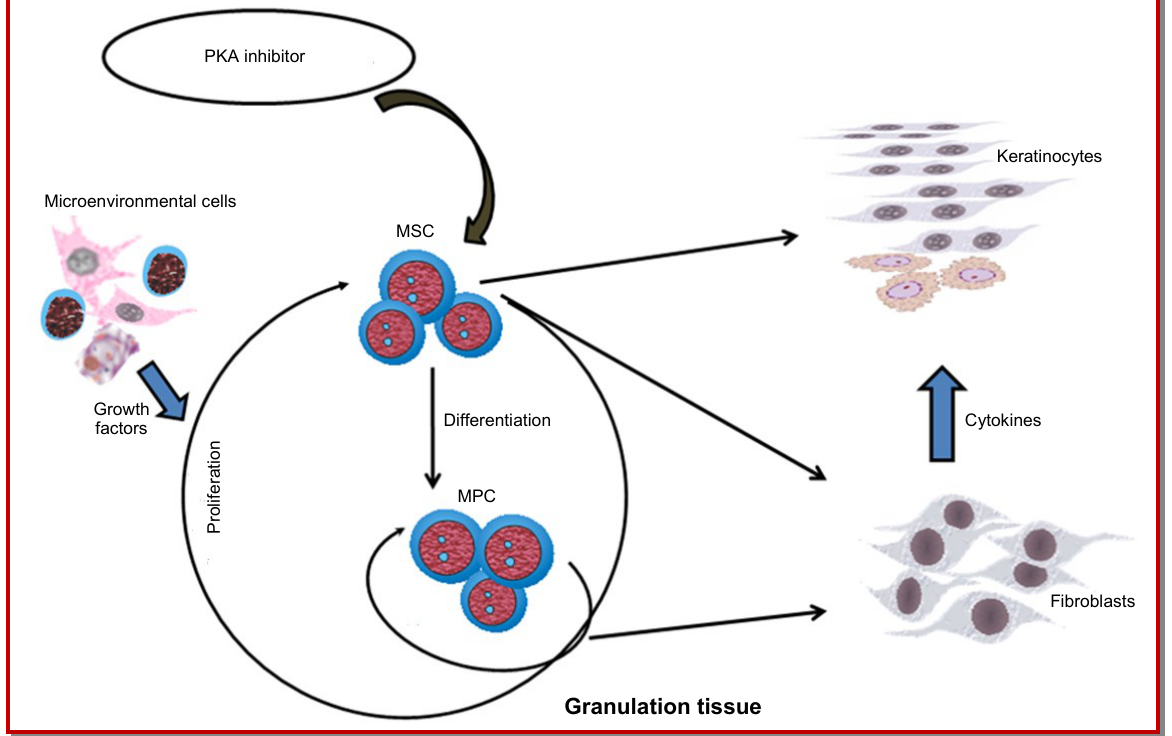
Figure 4: Mechanisms of wound healing action of protein kinase A inhibitor. MSC - multipotent mesenchymal stem cells, MPC – committed mesenchymal progenitor